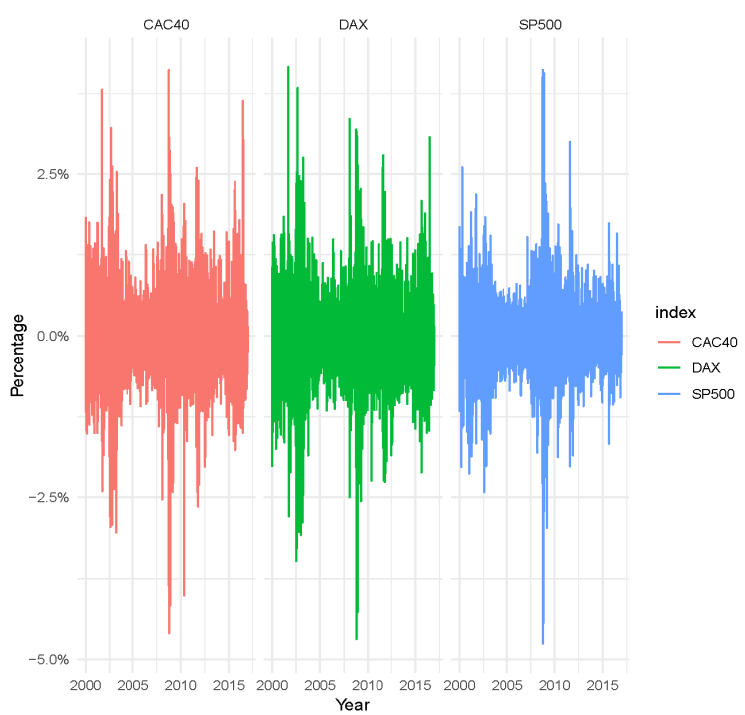
Figure 2. Daily losses (in percentage) of a portfolio that invests 100,000 units in the S&P 500 index, the DAX index, and the CAC 40 on 1 January 2000. The investment is equally split across the three